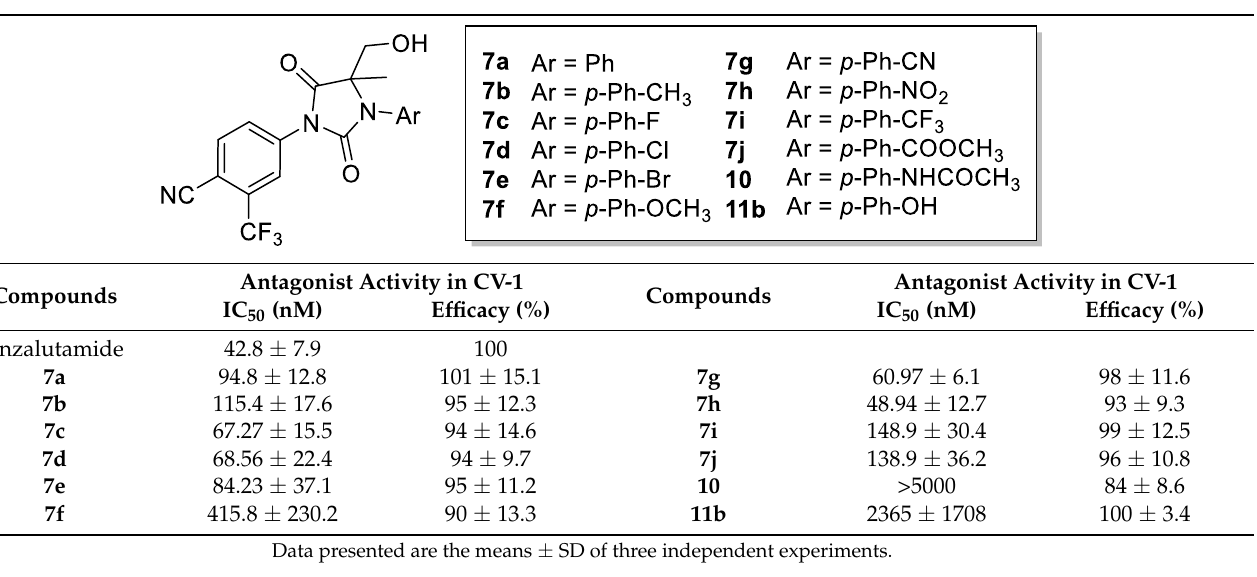
Table 2. Bioactivity of compounds 7a-j 10 and 11b .